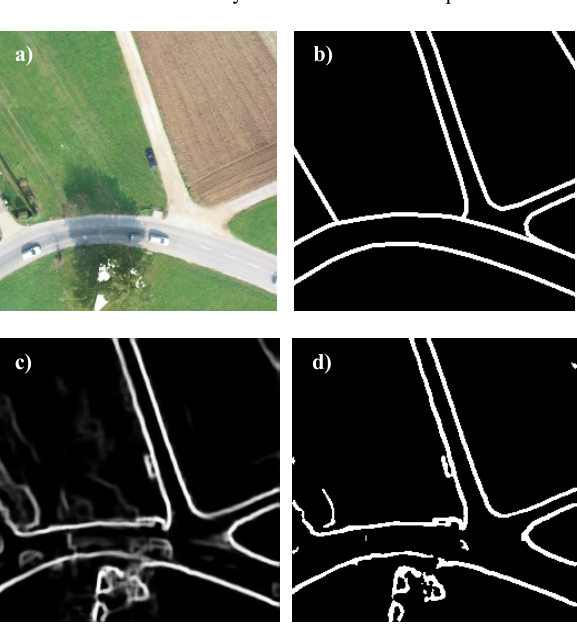
Figure 6. Predictions of the trained model based on U-Net. (a) Example 3 of tiled UAV image. (b) ground truth boundaries.